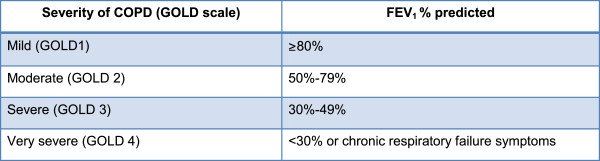
Classification of COPD. The limit is set out in international recommendations [15,16]. COPD, chronic obstructive pulmonary disease.